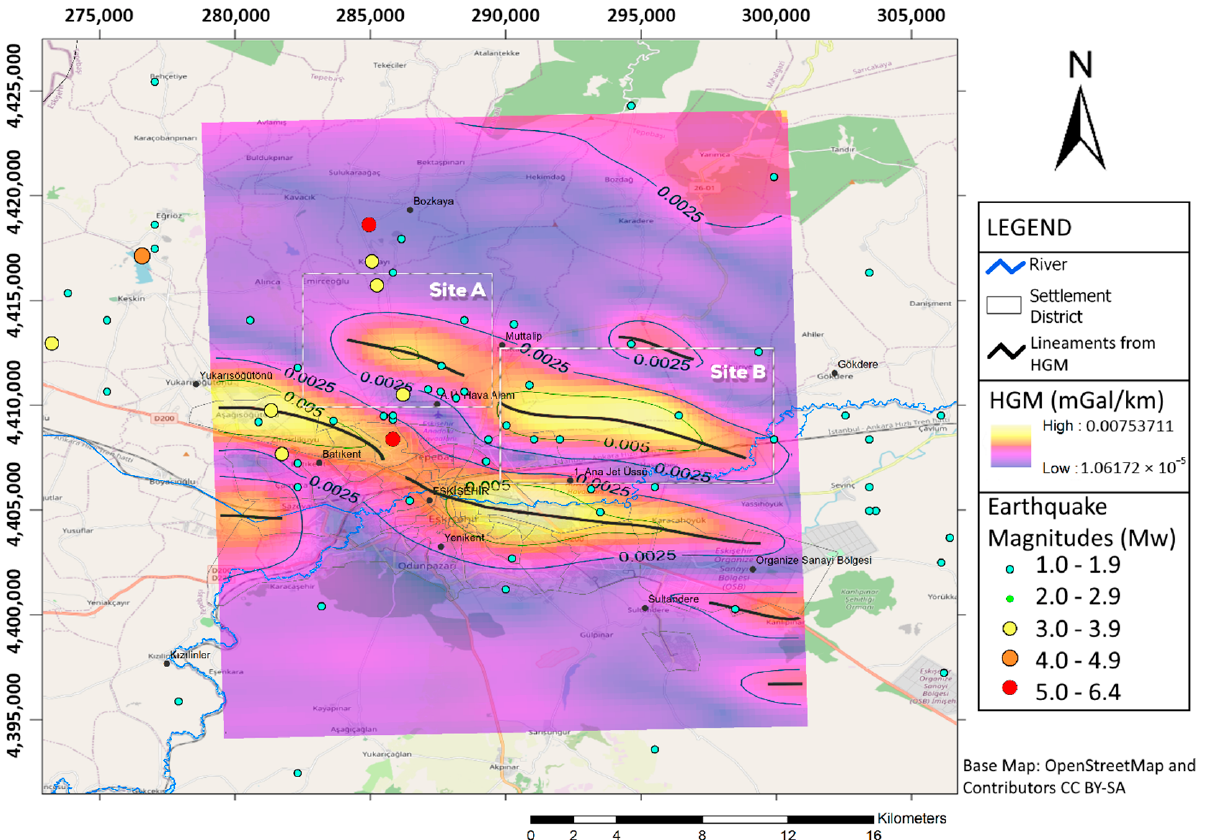
Figure 8. The Horizontal Gradient Magnitude (HGM) derived from gravity measurements with linearities indicating possible fault segments (url-4: https://www.openstreetmap.org/copyright accessed on 8 March 2022). (Datum: WGS84 UTM Zone 36